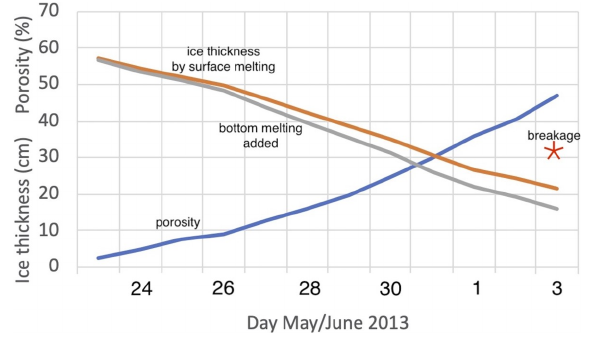
Figure 8. Field data for ice decay in Lake Kilpisjärvi in 2013 show- ing decrease in ice thickness by surface melting and bottom melting and increase in porosity until breakage of ice